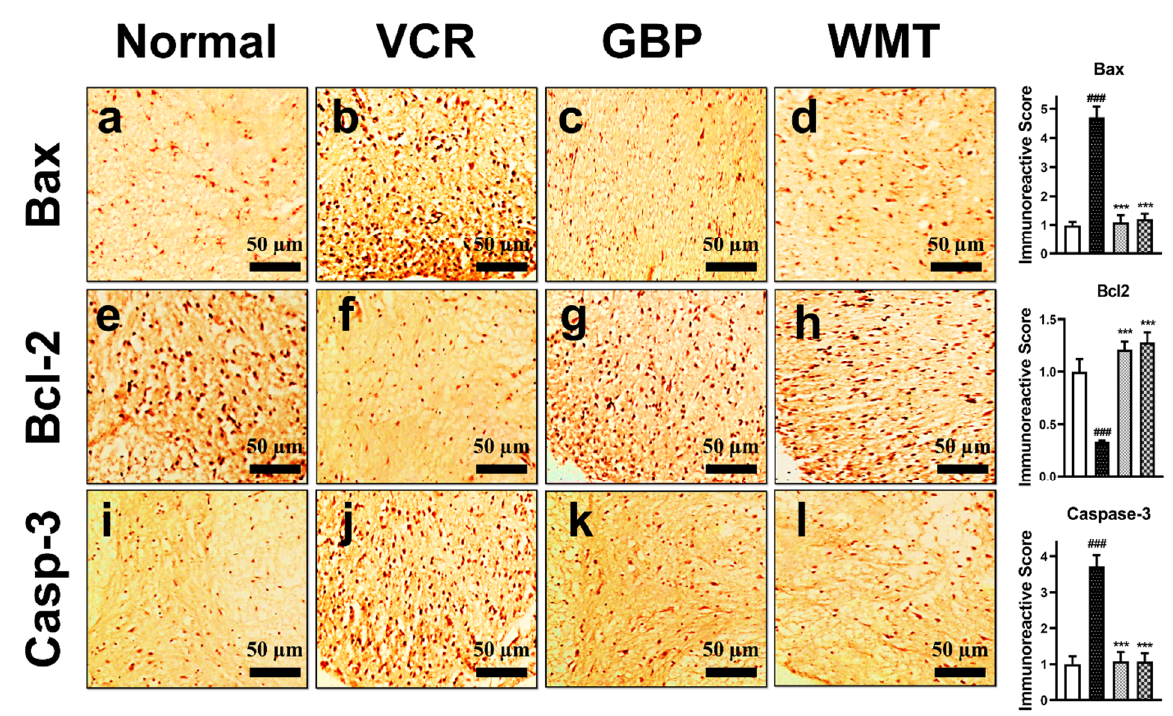
Figure 14. Effect of the withametelin treatment on the expression levels of Bax, Bcl-2, and caspase-3 proteins in the mouse spinal cords. Magnification 10×. Bax ( a – d ), Bcl-2 ( e – h ), and caspase-3 ( i – l ). All the results were expressed as the mean ( n = 3) ± SD. ### p < 0.001 vs. the control group. *** p < 0.001 vs. the VCR group.